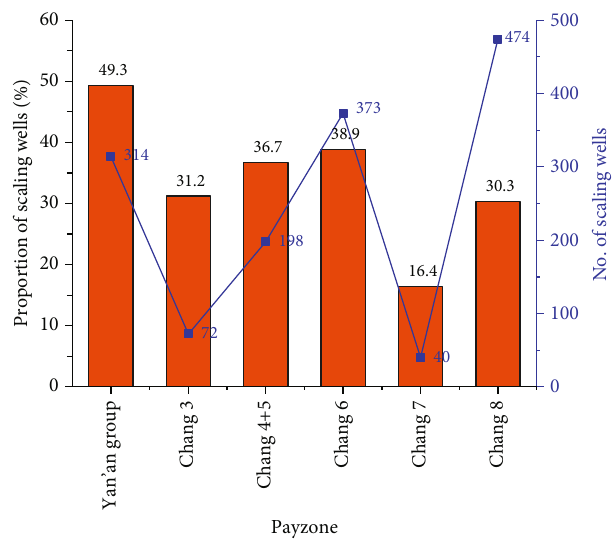
Figure 2: Number/proportion of scaling wells in the Huanjiang oil fi eld by payzones.